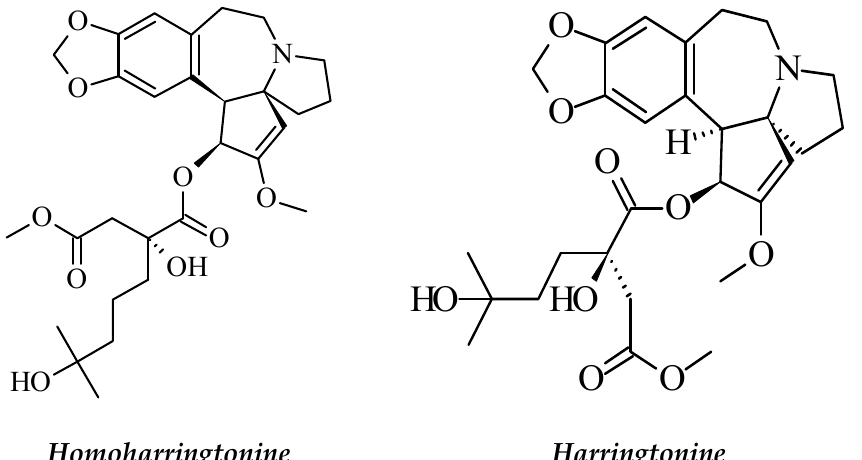
Figure 1. The structures of homoharringtonine and harringtonine.